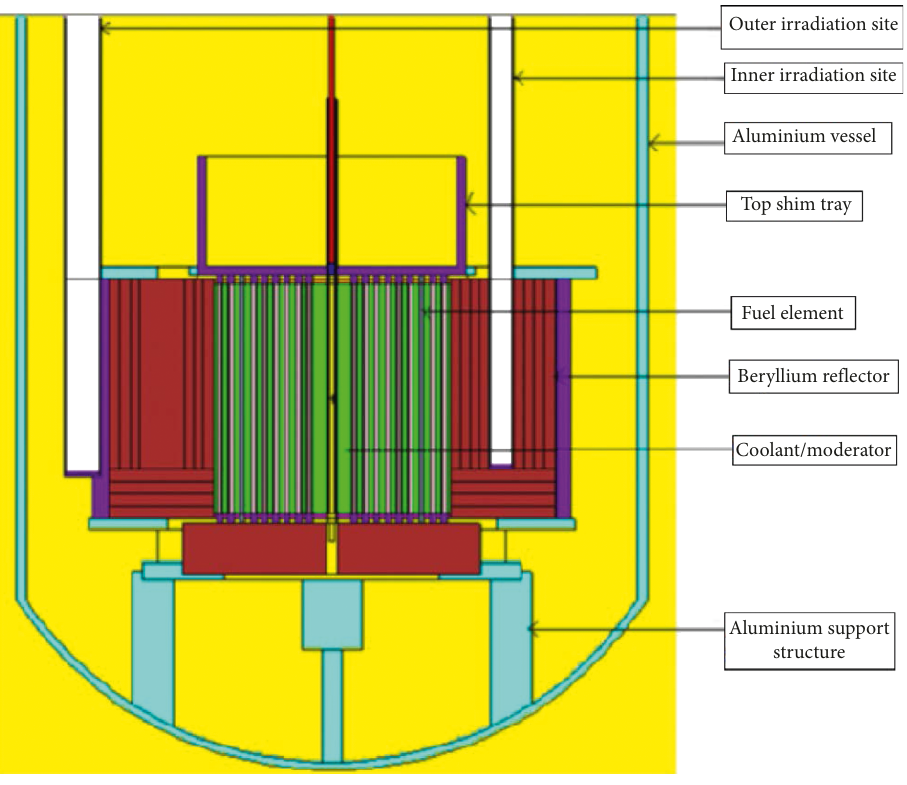
Figure 1: Vertical cross-sectional view of the GHARR-1 reactor.